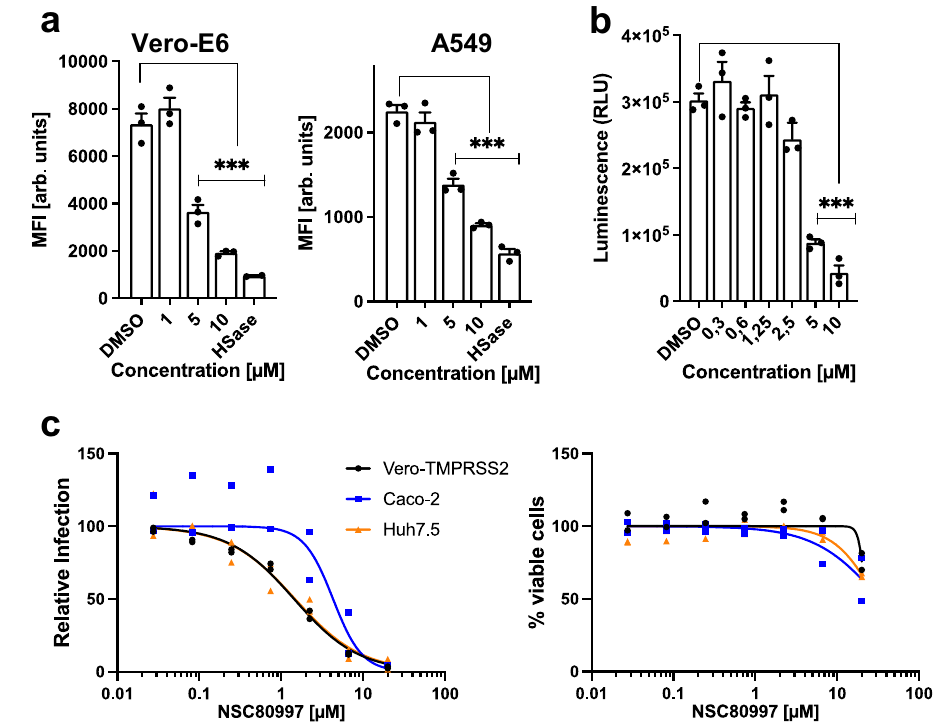
Fig. 7 | Reduction of cellular heparan sulfate by NSC80997 treatment inhibits binding and entry of SARS-CoV-2. a Cell surface binding of recombinant SARS- CoV-2 spike protein to Vero-E6 (left) and A549 (right) cells treated with increasing concentrations of NSC80997 or DMSO control for 24h or after heparinase treat- ment (HSase). Binding was assessed by fl ow cytometry and is presented as mean fl uorescence intensity (MFI)±SEM (arbitrary units) from 3 independent experi- ments.*** P <0.0001(ANOVA). b InfectionofNSC80997orcontrol-treatedVero-E6 cells with SARS-CoV-2 S protein pseudotypedvirus expressing luciferase.Infection wasmeasured bythe addition ofBright-Glo anddetectionof luminescence.Datais presented as mean relative light units (RLU)±SEM from 3 independent